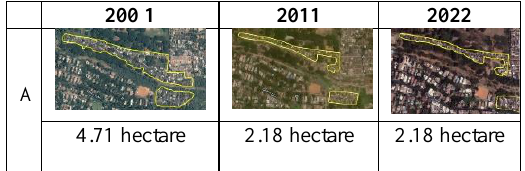
Figure 5. Zone wise slum population of Chennai district Figure 5 represents the zone-wise slum population of the Chennai. The result of the study mainly reveals that 28% of Chennai's urban population lives on 5.16% of the land. The slum population has been divided into four categories, and four samples have been taken from each category (4x4=16) of slums. The samples were collected for the years 2001, 2011, and 2022 from Google Earth Pro. The samples were used for the ground validation and to confirm the growth of